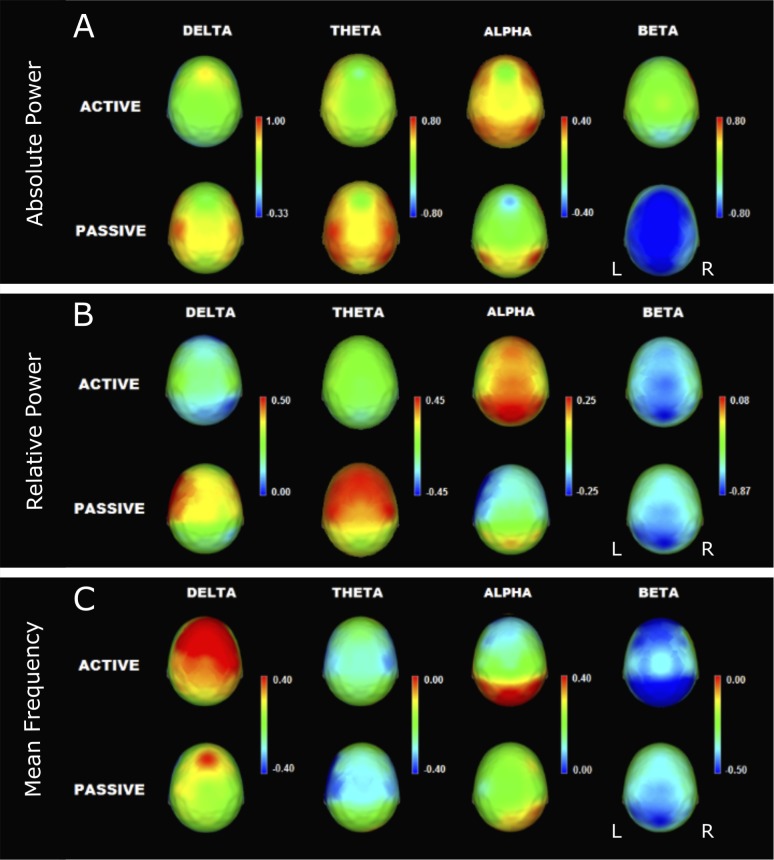
Mean Z values of absolute power (A), relative power (B) and mean frequency (C) in the active (upper, n = 48) and passive (bottom, n = 49) groups. Note that all values are within normal limits; however, the passive group has a slower EEG activity, which corresponds to higher power values in the delta and theta bands and lower power values in the alpha band. Mean frequency of the delta band indicates faster delta activity in the active group.